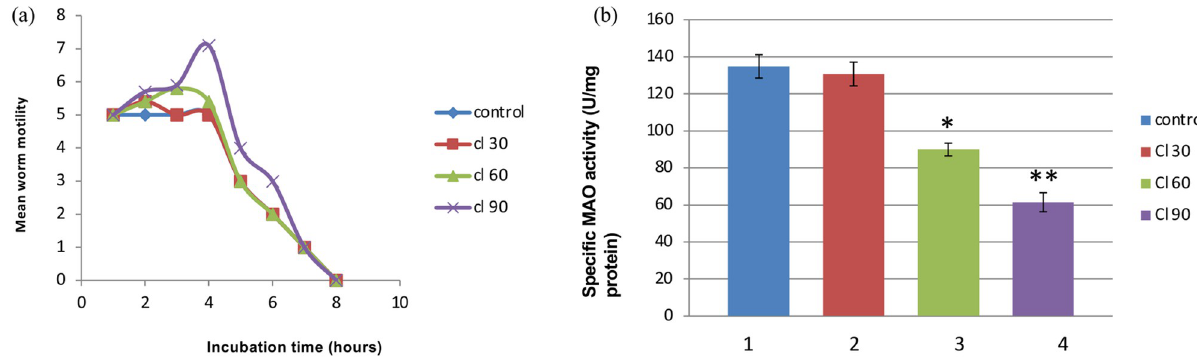
Fig 6. Motility of F . gigantica worms recorded at every 30 minutes over a period of 7 hours post incubation of parasites in different concentrations (30, 60 and 90 μ M) of clorgyline (a). Control was devoid of the specific inhibitor. In general, motility of worms upon administration of clorgyline first increased in a dose dependent manner and then decreased until complete immobility was evident. Grading system of motility was done by considering 1 as the least motile, 5 being highly motile and 7 being extremely motile. The specific enzyme activity of mitochondrial MAO-A in F . gigantica worms incubated in vitro with different doses of clorgyline (b). The adult F . gigantica worm treated with clorgyline at 30 μ M (2), 60 μ M (3) and 90 μ M (4) concentrations, while control (1) was devoid of any inhibitor. A minimum of 3 replicates were run and the data is expressed as a mean ± SEM. * p < 0.05, ** p < 0.01 were considered statistically significant.